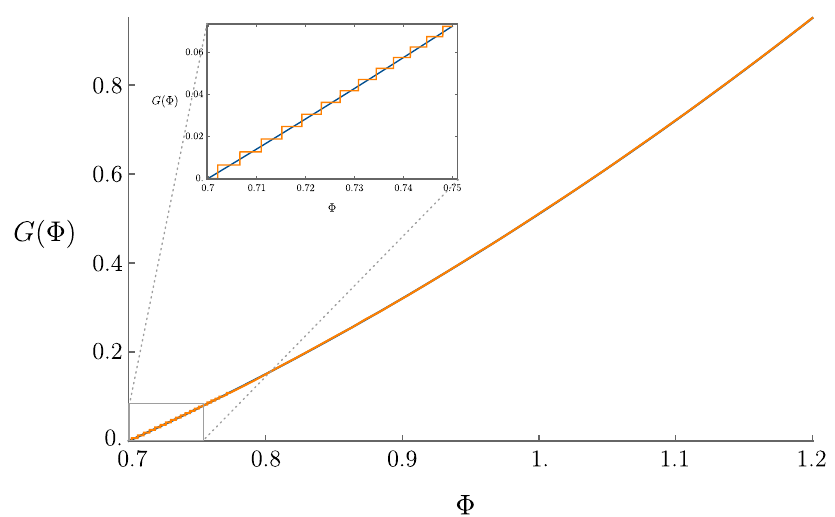
Figure 5 . Metric function G (Φ) as a function of the radial coordinate (equal to the dilaton Φ ) for the potential U (Φ , s 0 ) with s 0 = 1 (orange) alongside with the undeformed metric potential Φ 2 − Φ 2 . We used Φ h = 0 . 7 and took the first 1500 eigenvalues of H JT at S 0 = 5 . The inset shows h a clear difference between the two cases, but on ‘average’ (average over a small Φ window) the blue and orange curve lie on top of each